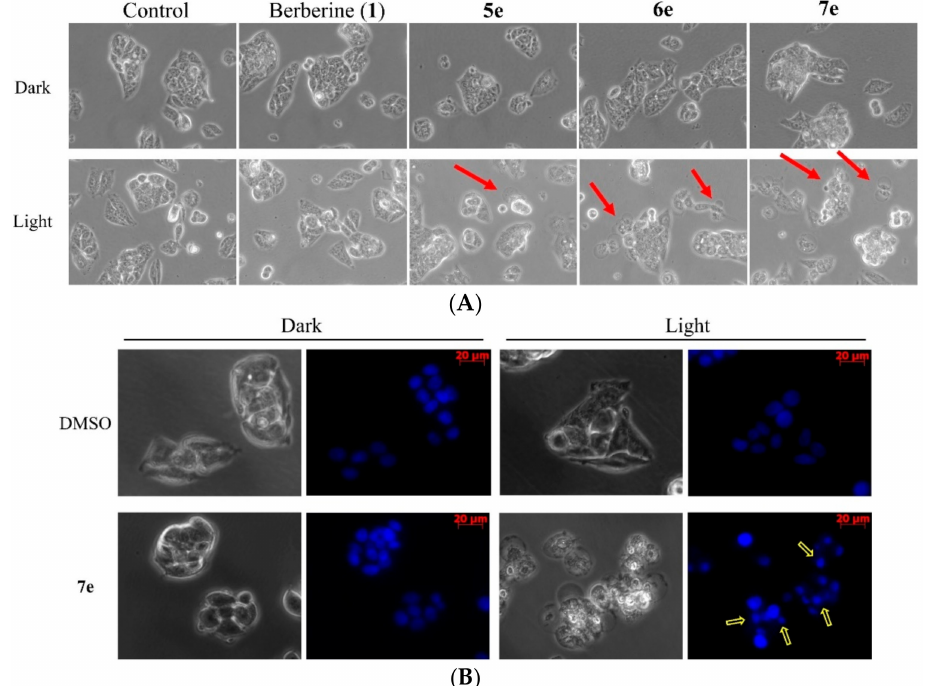
Figure 6. Morphological changes in HepG2 cells treated with berberine ( 1 ), 5e , 6e, or 7e at 0.5 µ M at the dark or light (420 nm, 10 min) for 4 h (magnification, 200 × ). ( A ) Upper panels show the cell morphology under phase-contrast microscopy, red arrows indicate the apoptotic cells. ( B ) HepG2 cells were treated with 7e (0.5 µ M) for 4 h by irradiation and stained with Hoechst 33258 staining nuclear patterns detected through fluorescence microscopy (magnification, 200 × ). The yellow arrows indicate the apoptotic cells by